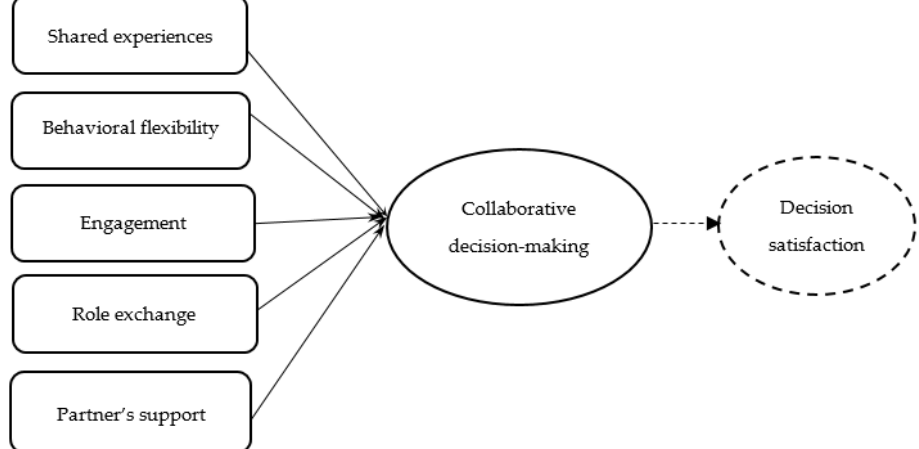
Figure 1. Suggested conceptual model of collaborative decision-making in